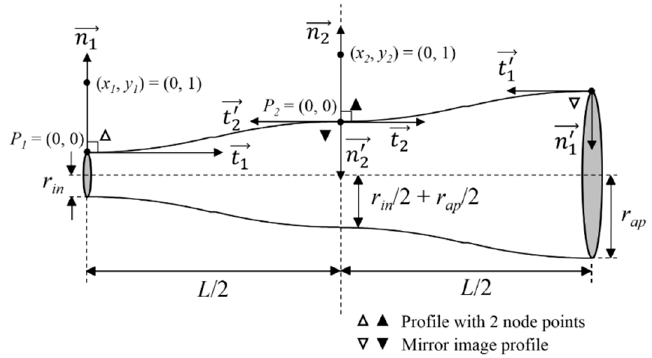
Figure 3. Geometry of mirror image profile horn antenna (having 3 node points) using biarc Hermite polynomial interpolation with principal unit normal vector points as ( x 1 , y 1 ) = ( x 2 , y 2 ) = (0, 1); r in = 0.8 mm; r ap = 8.50 mm; L = 50 mm for center frequency of 140 GHz.